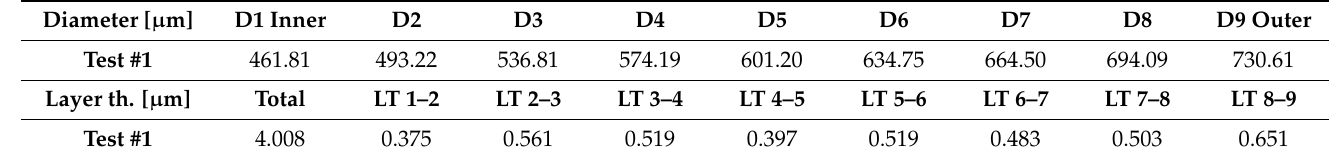
Table 2. Protocol of the period and total coating thickness measurement by calotest.